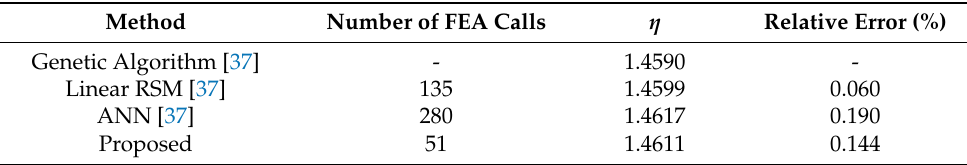
Table 6. Result comparison using different methods for Example 3.